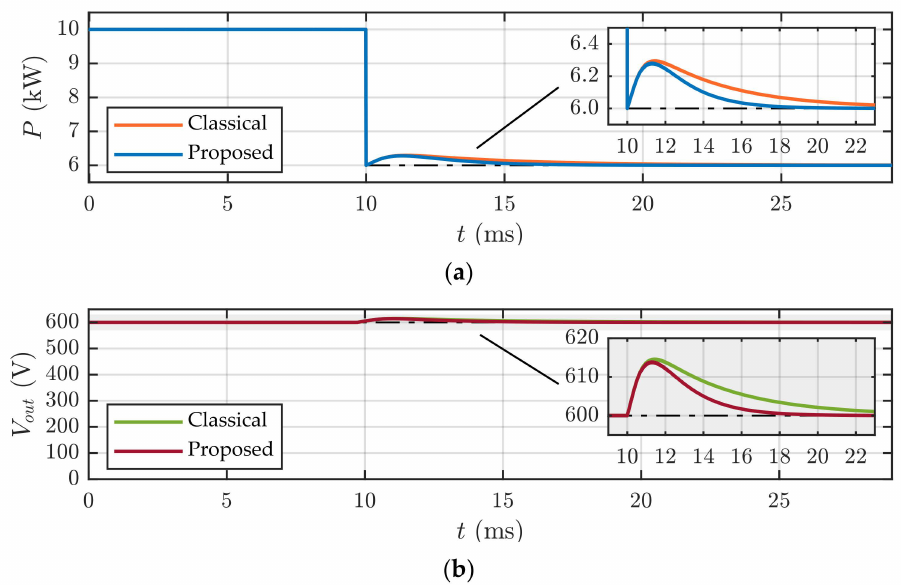
Figure 16. Output power ( a ) and output voltage ( b ) change on the DC bus when load changes from 10 kW to 6 kW of both classical pole-placement and proposed control